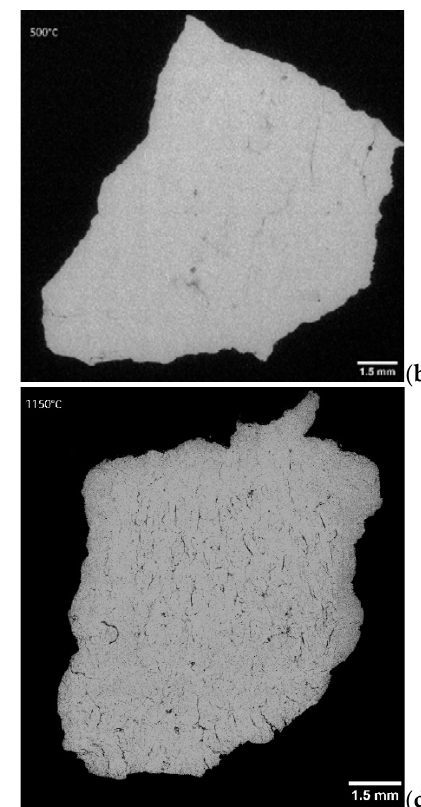
Figure 4. The PLS ‐ DA score plot for the two first components colored according to classes ( a ) and the corresponding loading plot ( b ).